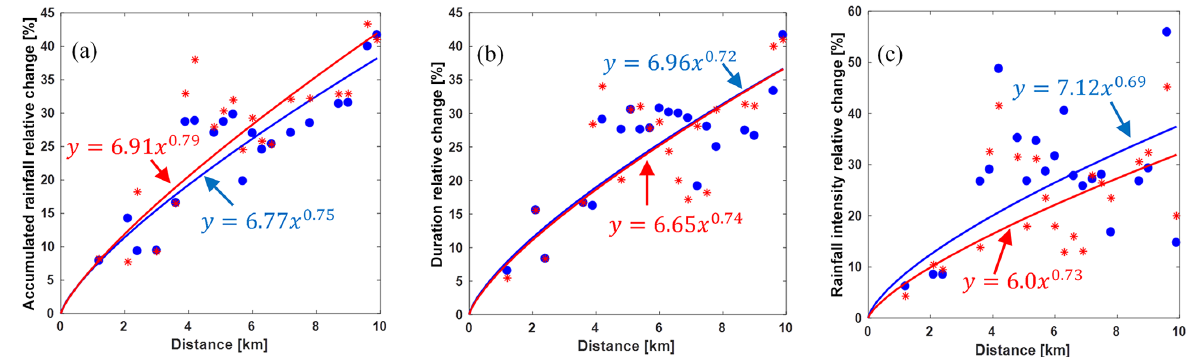
Figure 13. Scatter plot of relative changes versus distance. Blue circles represent relative change between radar estimate at debris flow location and rain gauge observation nearest to debris flow location. Red asterisks represent relative change between radar estimate at debris flow location and radar estimate at the co-location of the nearest rain gauge. (a) Accumulated rainfall relative change. (b) Duration relative change. (c) Rainfall intensity relative